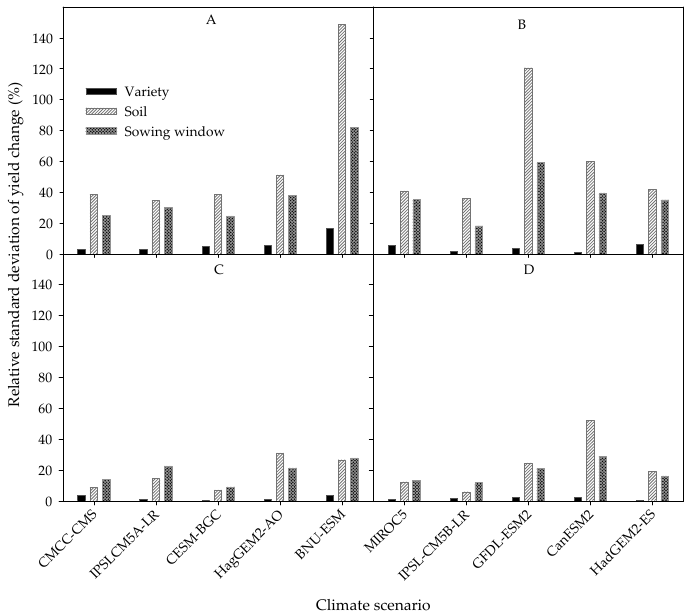
Figure 11. Source of variation for soybean yield under ambient CO 2 (( A ) RCP 4.5, ( B ) RCP 8.5) and under elevated CO 2 (( C ) RCP 4.5 and ( D ) RCP 8.5).